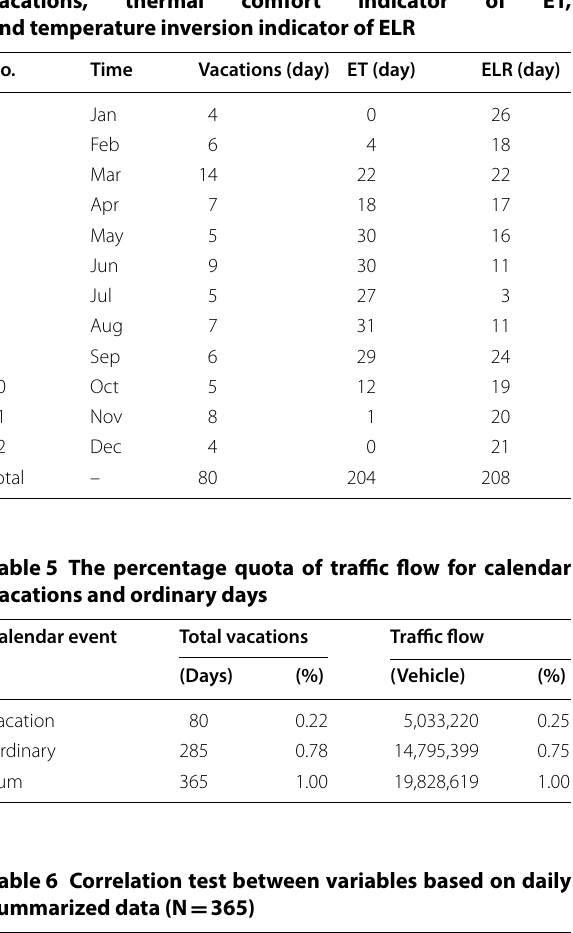
Table 4 Monthly distribution of total days with calendar